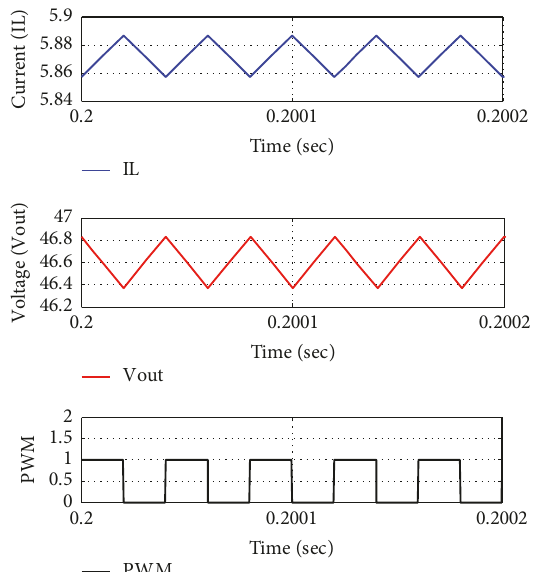
Figure 4: Waveforms of inductor current ( 𝐼 𝐿 ) and output voltage ( 𝑉 𝑜𝑢𝑡 ) in CCM.